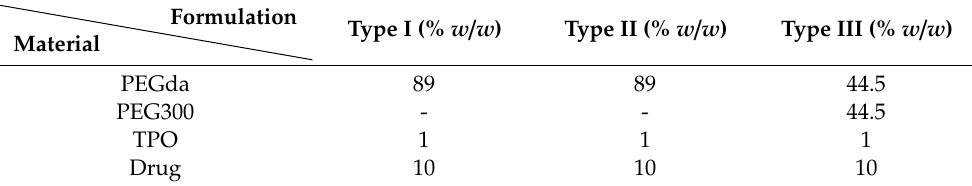
Table 1. Compositions (% w / w ) of the initial resins for printing.